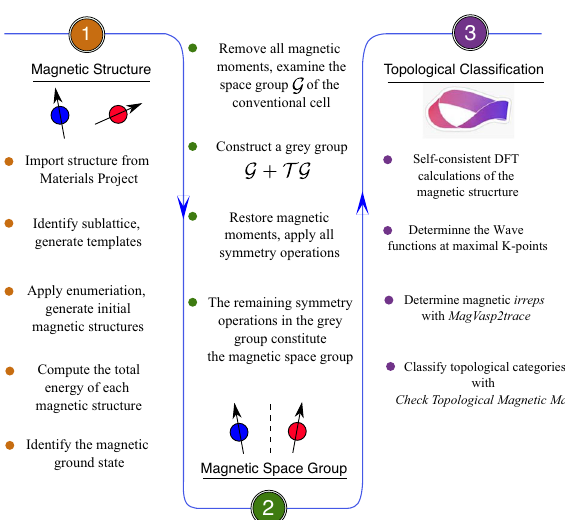
Fig. 1 Diagnosis work fl ow for high-throughput prediction of collinear magnetic topological materials. The work fl ow consists of three major steps: (1) Identi fi cation of collinear magnetic structure. (2) Determination of the corresponding magnetic space group. (3) Classi fi cation of the topological categories with